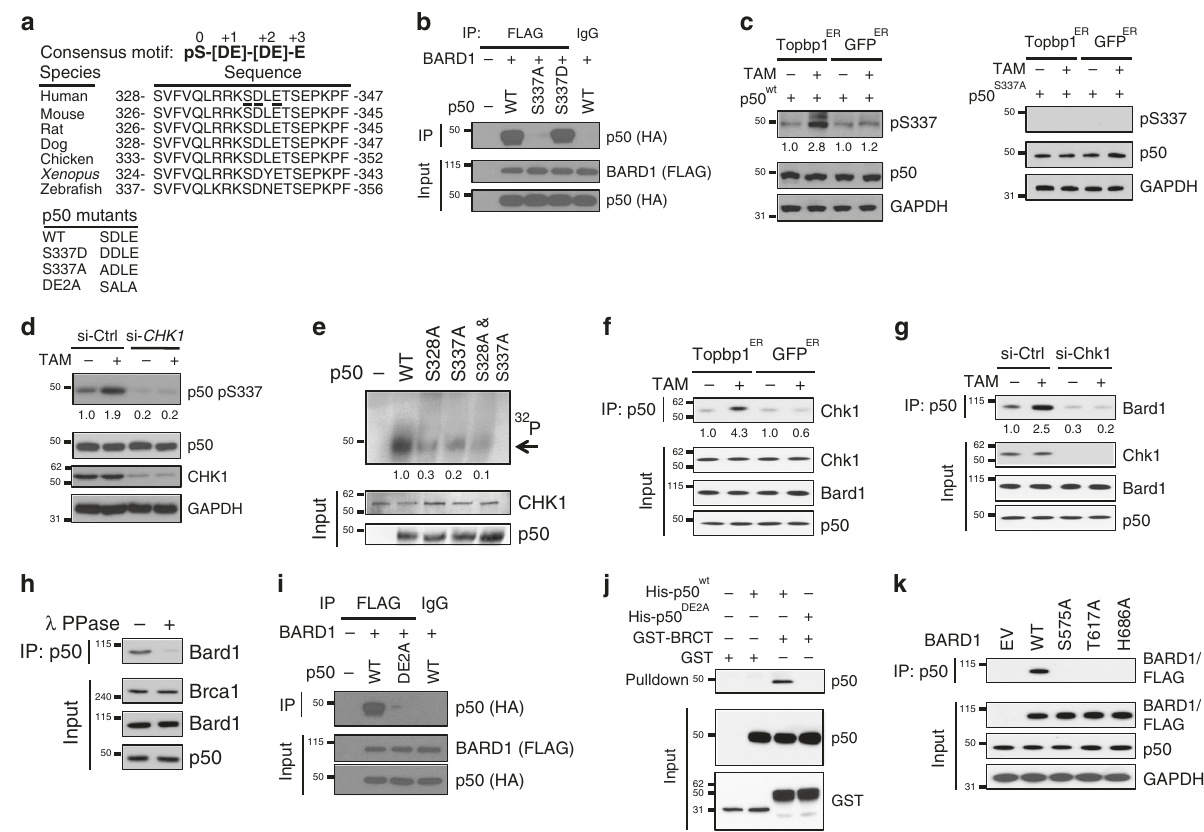
Fig. 2 BARD1 interacts with a conserved p50 phospho-serine motif. a Putative BARD1 BRCT-binding motif. Motif in human p50 is underlined. Sequence of p50 mutants (lower). b 293T cells expressing FLAG-BARD1 and the indicated HA-p50 construct. IP and IB performed with the indicated antibodies. c 293T cells expressing TopBP1 ER or GFP ER transfected with p50 wt (left) or p50 S337A (right) and treated with vehicle or TAM (4 h). IP with anti-HA and IB with anti-phospho-p50-S337 antibody. d 293T cells expressing TopBP1 ER were transfected with si-CHK1 or si-control and treated with vehicle or TAM. IB was performed with the indicated antibody. e Kinase assay with bacterially expressed p50 wt or the indicated p50 mutant and recombinant CHK1. Autoradiogram ( 32 P) and IB with indicated antibody of the same membrane. Arrow, phosphorylated p50. f Co-IP in primary WT MEFs expressing TopBP1 ER or GFP ER treated with vehicle or TAM (4 h). IP with anti-p50 and IB with the indicated antibody. g WT MEFs expressing TopBP1 ER transfected with si-CHK1 were treated with TAM (4 h). IP with anti-p50 and IB with the indicated antibody. h Co-IP in WT MEFs following endogenous IP with anti-p50 and IB with anti-Bard1 or the indicated antibody. Lysates were treated with lambda phosphatase ( λ PPase) or vehicle as indicated. i Co-IP in 293T cells expressing FLAG-BARD1 and the indicated HA-p50 construct. IP with anti-FLAG and IB with anti-HA antibody. j Nickel column puri fi cation of 6His-p50 wt or 6His- p50 DE2A incubated with GST-BRCT or GST alone. IB of eluted protein performed with anti-p50 antibody. k Co-IP in 293T cells transfected with empty vector (EV) or the indicated FLAG-BARD1 construct. IP was performed with anti-p50 and IB with anti-FLAG. All blots are representative of at least two biologically independent experiments. Analysis of fold-change normalized to control lane shown below IB where